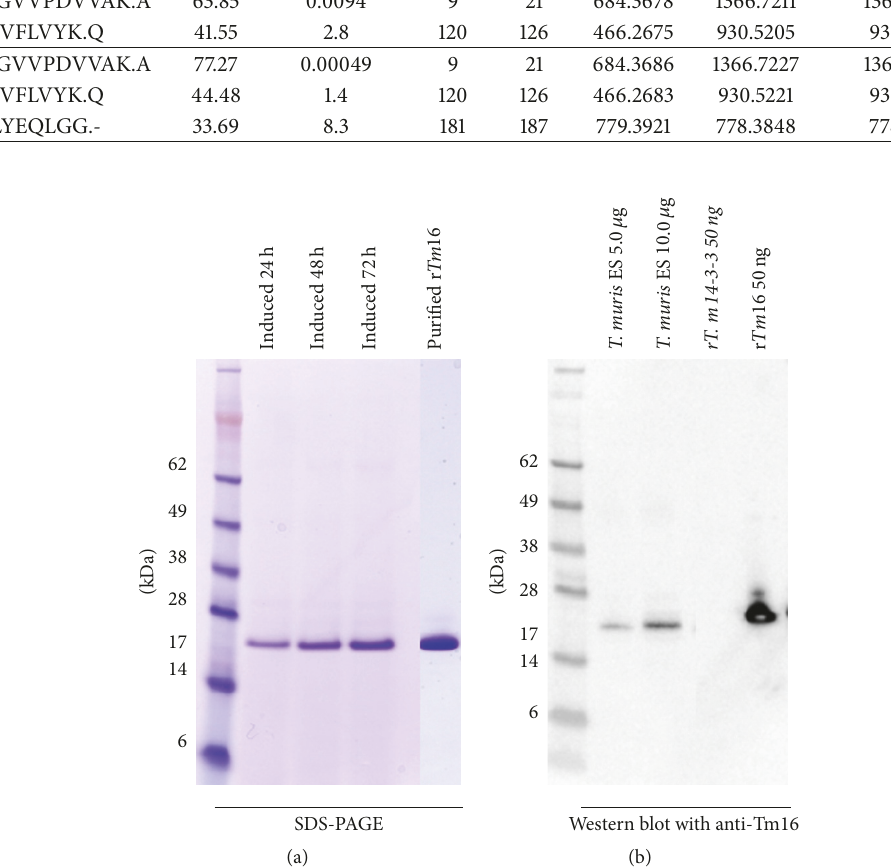
Figure 3: Production and localization of Tm16. (a) SDS-PAGE of ∼ 2 𝜇 g rTm16 expressed in P. pastoris X-33 after being induced with 5% methanol for 24–72 hours and IMAC purification. (b) Western blot showing the native Tm16 is in the T. muris ES products; rTm16 is slightly larger than the protein in the ES because it has a hexahistidine tag. The rTm14-3-3 (50ng) was used as a negative